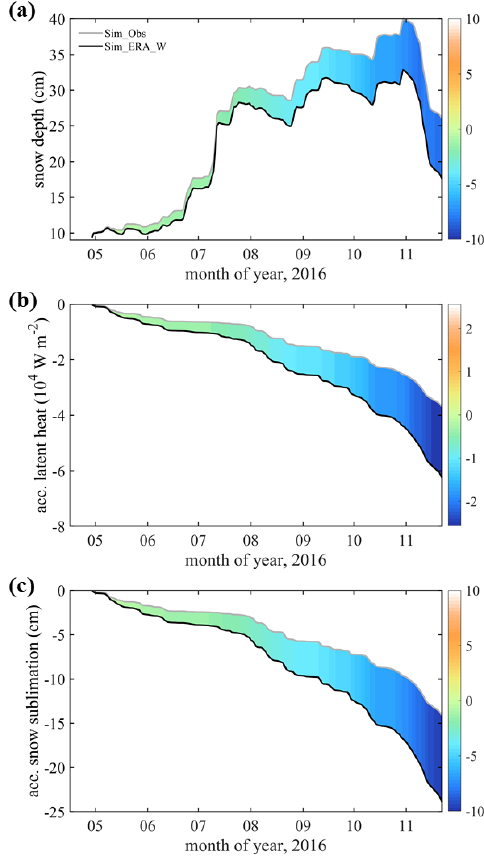
Figure 9. Times series of (a) snow depth, (b) accumulated la- tent heat flux, and (c) accumulated snow sublimation. The gray line represents the simulation using wind from the observations (Sim_Obs). The black line represents the simulation using wind from ERA5 (Sim_ERA_W). The color bar represents their differ- ence (Sim_ERA_W −